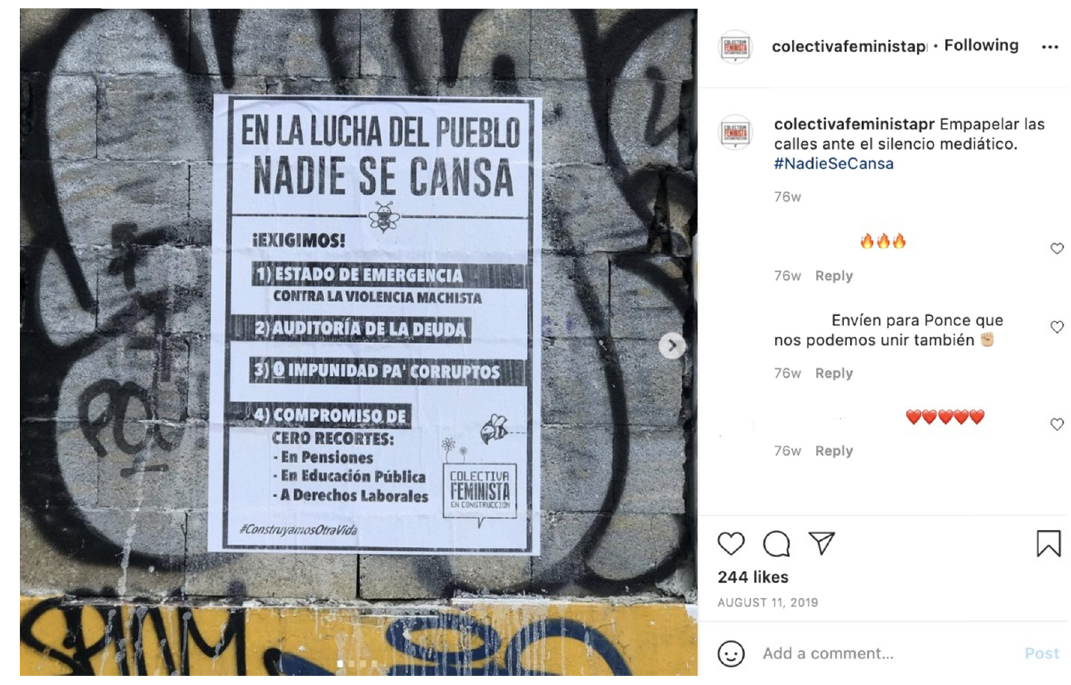
Figure 8: Screenshot from Colectiva Feminista en Construcción Instagram